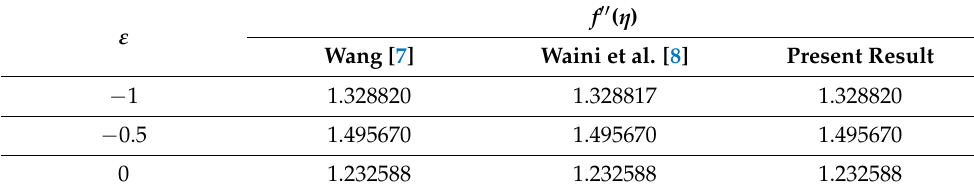
Table 3. Comparison results where Sb = λ = M = Ec = Rd = Sc = K = 0 and ϕ 1 = ϕ 2 = 0 when Pr = 6.2.